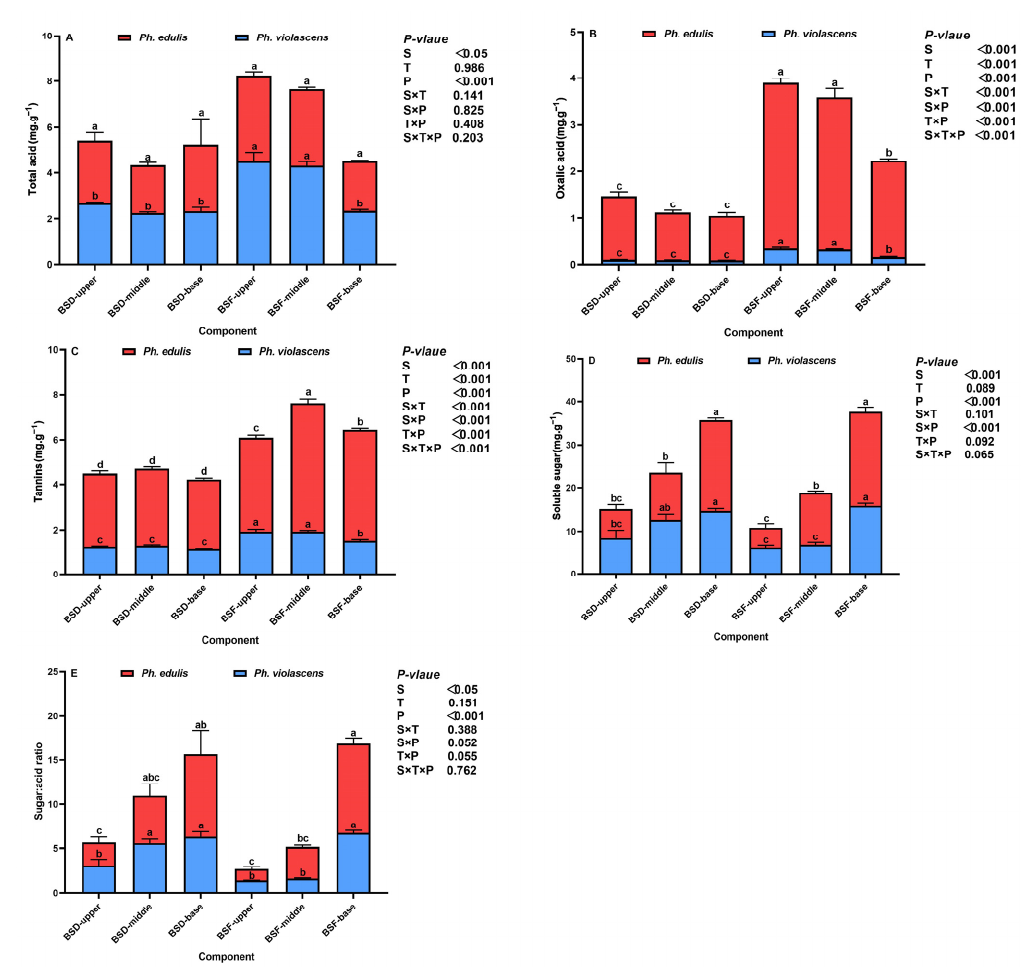
Figure 3. Changes in the nutritional status of bamboo shoot diaphragm (BSD) and flesh (BSF) in Ph. edulis and Ph. violascens . ( A ) total acid, ( B ) oxalic acid, ( C ) tannins, ( D ) soluble sugar, and ( E ) the sugar:acid ratio. BSD and BSF refer to bamboo shoot diaphragm and flesh, respectively. Vertical bars are means ± SD of the four replicates. Different lowercase letters above the bars in each graph represent significant differences ( p < 0.05) between the bamboo shoot segments. p values are only shown for the main and interactive effects of species (S), component (C), and position (P), respectively, for each indicator.